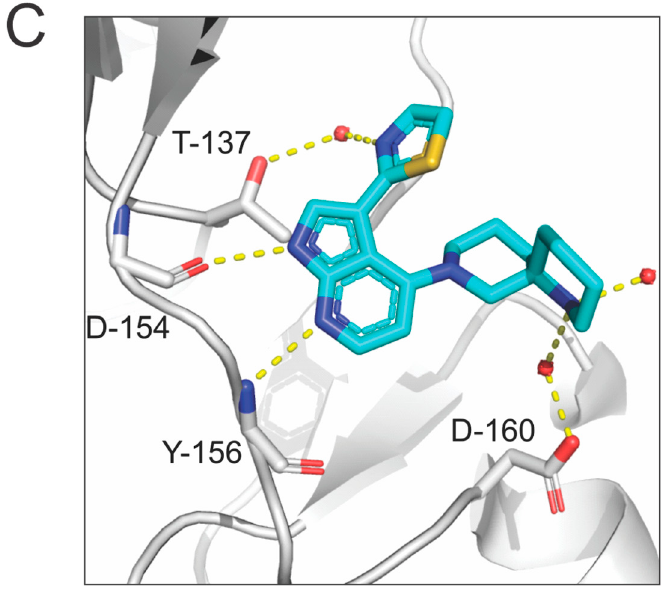
Figure 8. X-ray co-crystal structures of inhibitors and MRCK β . ( A ). Co-crystal structure of the MRCK β kinase domain in complex with BDP9066 (PDB 5OTF) [20]. ( B ). Co-crystal structure of the MRCK β kinase domain in complex with BDP5290 (PDB 4UAL) [20]. ( C ). Co-crystal structure of the MRCK β kinase domain in complex with BDP8900 (PDB 5OTE) [28]. Protein residues are represented by a single-letter amino acid code and residue number. Water molecules are represented by red spheres and hydrogen bonds are highlighted with yellow dotted